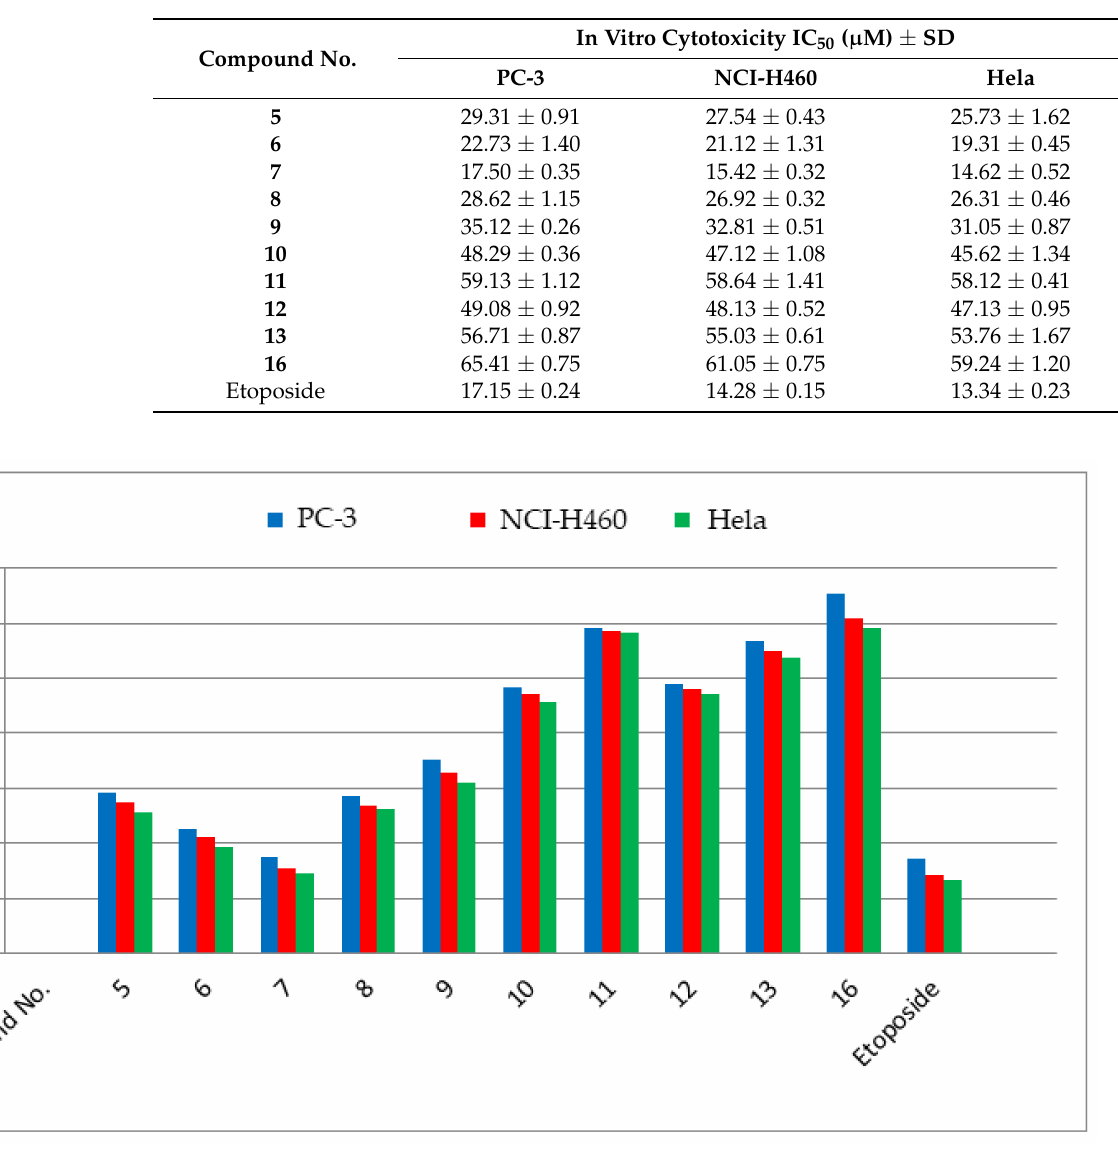
Figure 2. In vitro cytotoxic results of the target compounds 5 – 13 , 16 and etoposide towards PC-3, NCI-H460 and Hela cell